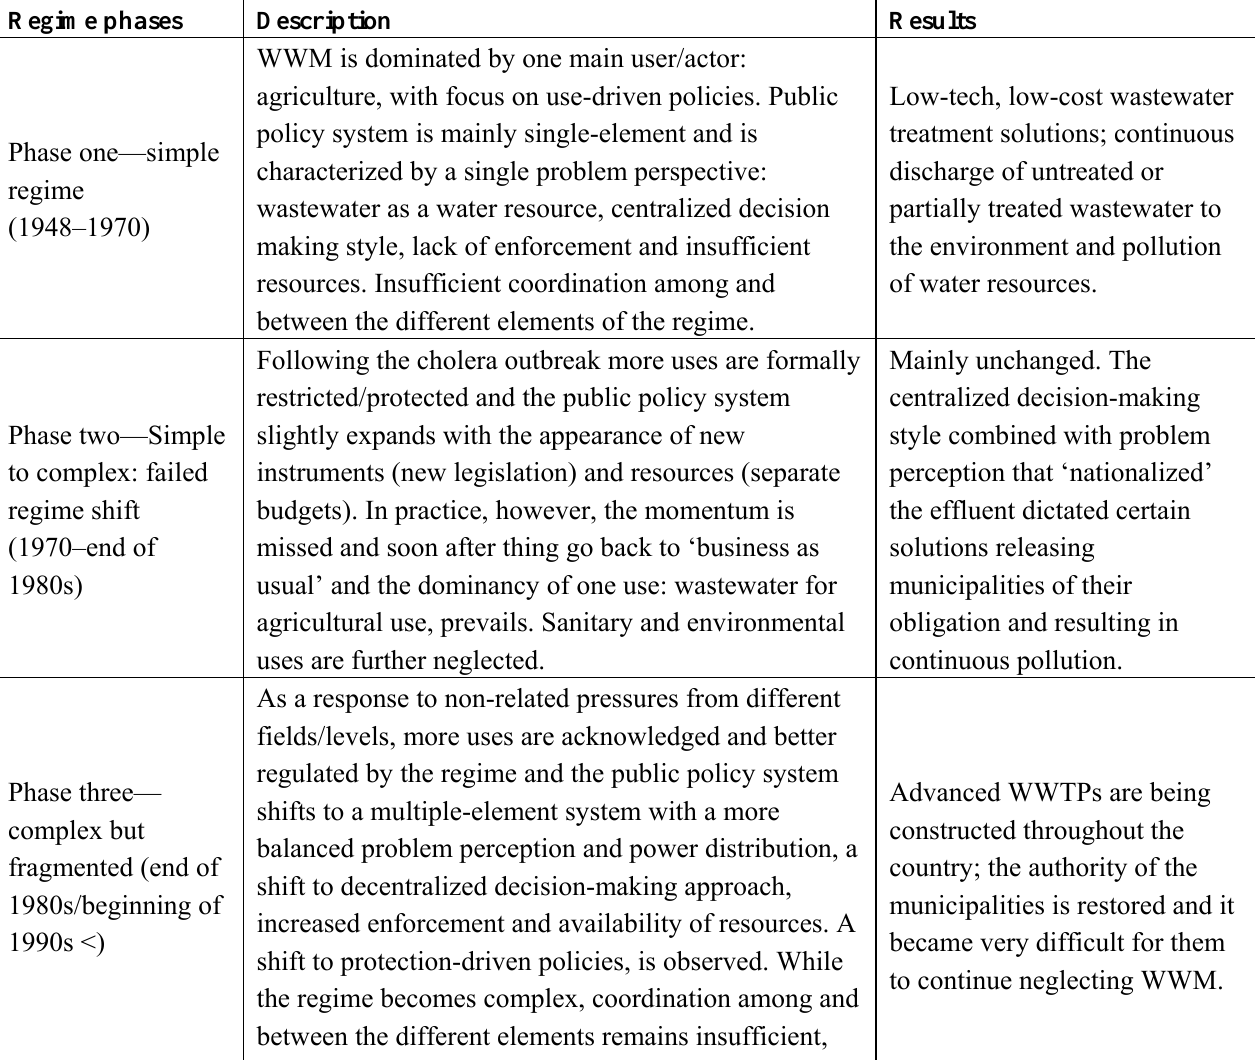
Table 1. WWM regime evolution in